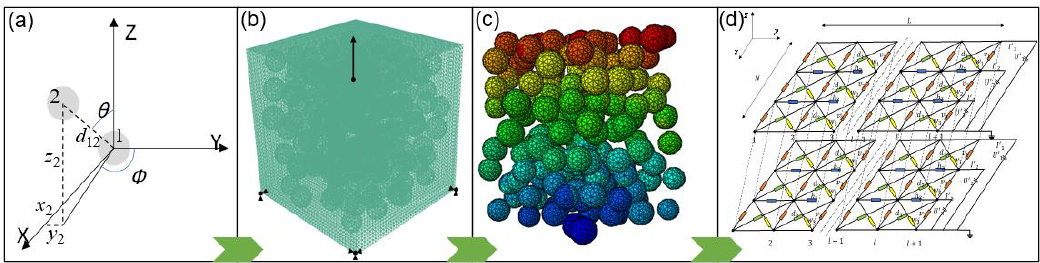
Figure 1. Steps of the multiscale analysis method: ( a ) improved NNA method; ( b ) RVE model; ( c ) FE analysis; ( d ) equivalent resistance calculation.